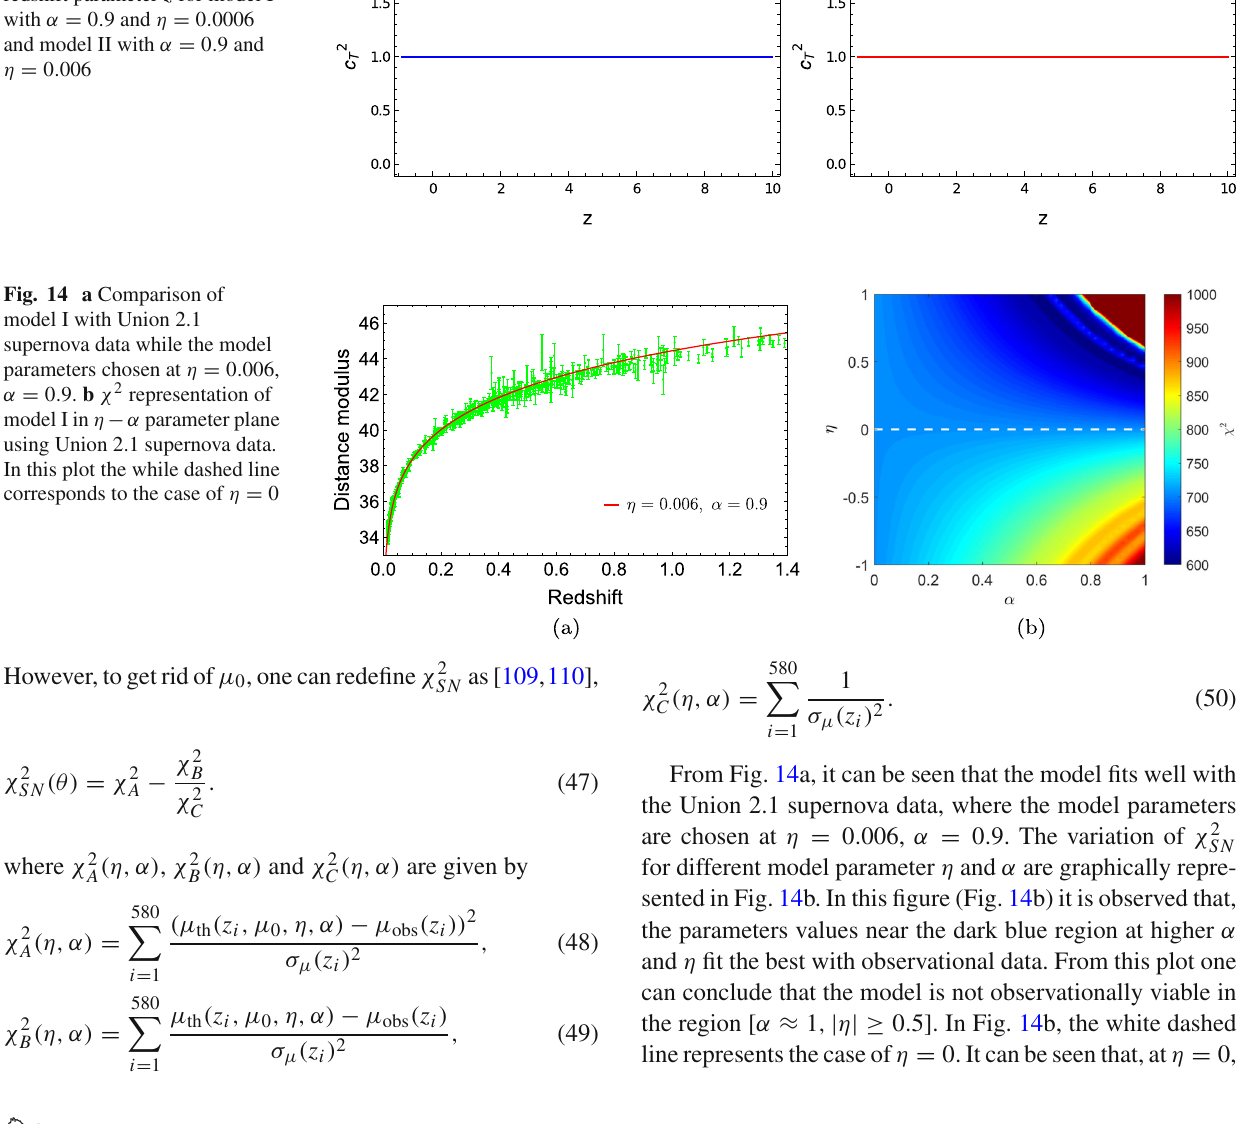
Fig. 12 a Evolution of q ( z ) and j ( z ) for different values of η and α in the case of model I. b Parametric representation of q ( z ) , j ( z ) and Om ( z ) for different chosen sets of model parameters η and α in the case of model I Fig. 13 Variation of the gravitational wave speed with redshift parameter z for model I with α = 0 . 9 and η = 0 . 0006 and model II with α = 0 . 9 and η = 0 . 006